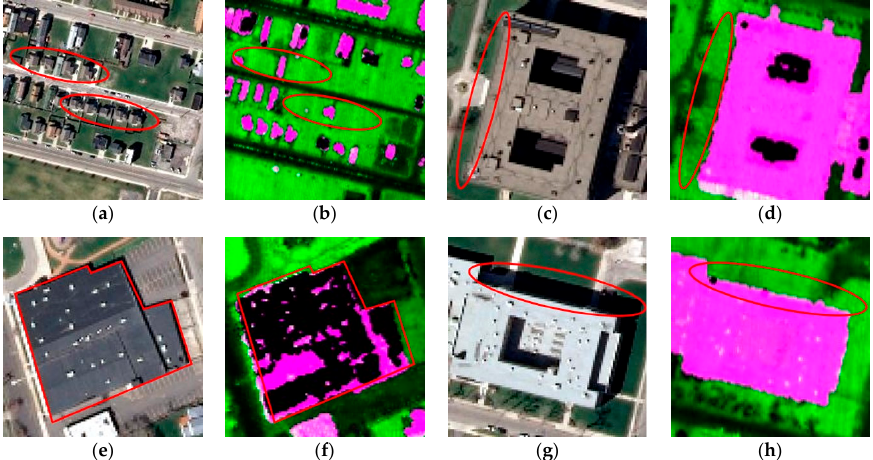
Figure 2. The changes and observation difference between the multi-temporal high-resolution image and light detection and ranging (LiDAR) data are highlighted by red circles or polygons, and all LiDAR data is displayed in pseudo-color raster image (red band and blue band: normalized Digital Surface Model (nDSM), green band: intensity). Above: ( a ) high-resolution image after changes; ( b ) LiDAR data before changes; ( c ) high building in the high-resolution image with mis-registration; ( d ) high building in the LiDAR data with mis-registration; ( e ) high-resolution image without missing data; ( f ) LiDAR data with missing data; ( g ) high-resolution image with shadows; and, ( h ) LiDAR data without shadows.